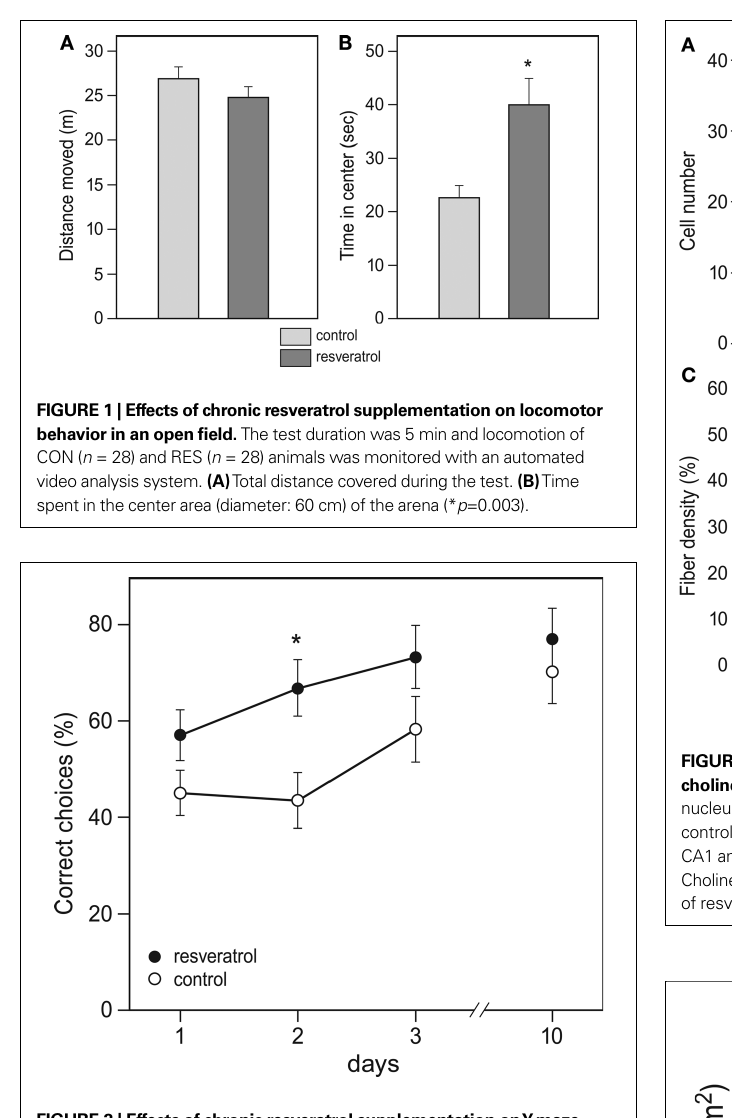
FIGURE 2 | Effects of chronic resveratrol supplementation on Y-maze learning. The Y-maze test consisted of 3 training days and a retention day 1 week later. Each day consisted of eight trials and the performance of the animals is expressed as the percentage of correct choices per day. RES animals ( n = 28) show faster acquisition of the task then CON animals ( n = 28), as shown on day 2 (* p = 0.016).